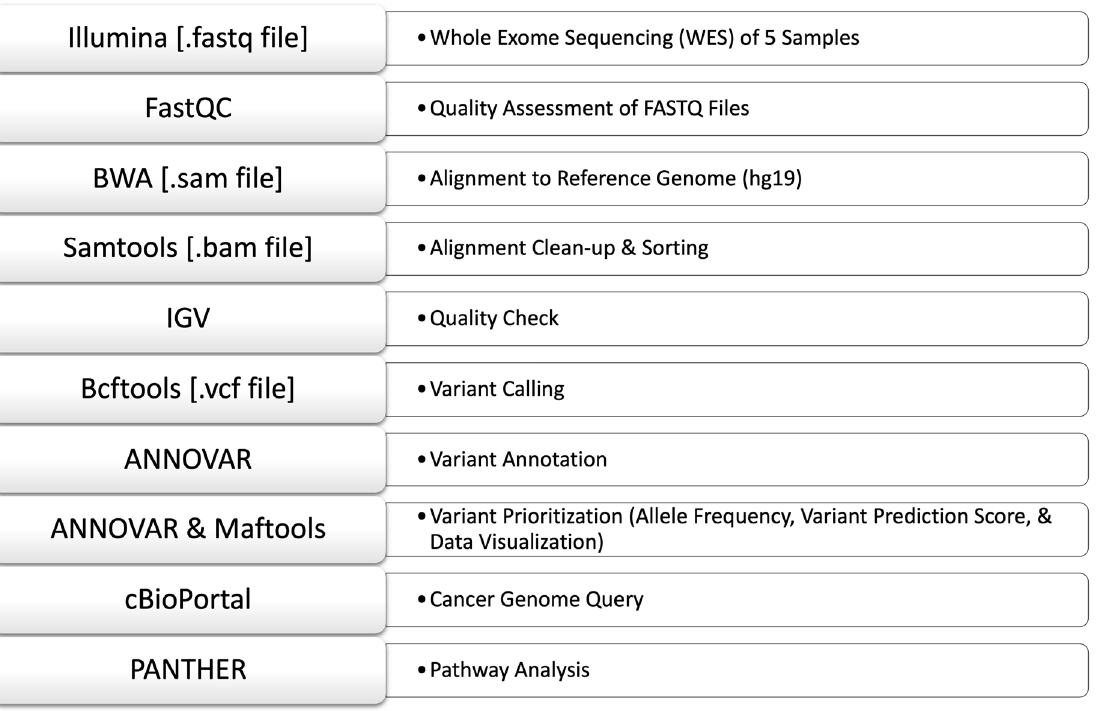
Figure 5. WES data analysis pipeline implemented in this study.